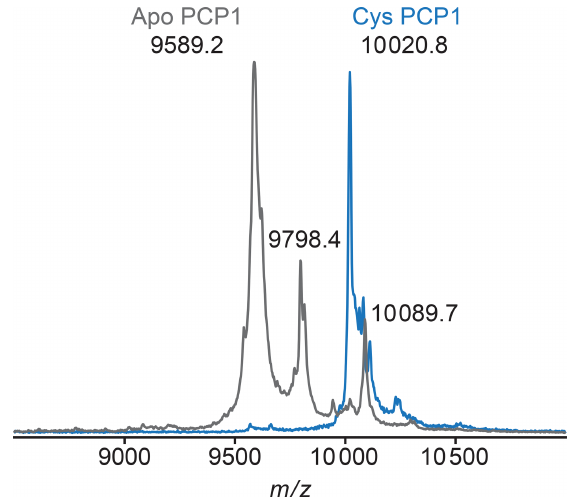
Figure A2. MALDI-TOF mass spectrometry is used to confirm loading of PCP1. To confirm loading of PCP1 with an orthogonal method, the mass-to-charge ratio of PCP1 approximates loading of the prosthetic group. Apo PCP1 shows a characteristic mass shift upon loading of the prosthetic. Here, an experimental mass change of 431.6Da was observed. A theoretical mass change of 426.4Da is expected upon loading of PCP1. Peaks at a m/z of 9798.4 and 10089.7 in apo are artifacts of MALDI sample preparation (e.g., matrix adduct with sinapinic acid). For comparison, the MALDI- TOF spectrum of Cys PCP1 has been scaled up by a factor of 3 as the sample was more dilute. All MALDI-TOF spectra were col- lected on a Voyager DE-STR (Applied Biosystems) spectrometer in linear mode using a mass range of 2500 to 25000Da. Sinapinic acid (10mgmL − 1 in 50% acetonitrile / 0.1% trifluoroacetic acid, TFA) was applied as a sample matrix using a 10-fold dilution of pro- tein sample in 0.1% TFA. Spectra were calibrated against standards ranging from 5734.51 to 16952.30Da (Protein Calibration Standard I,